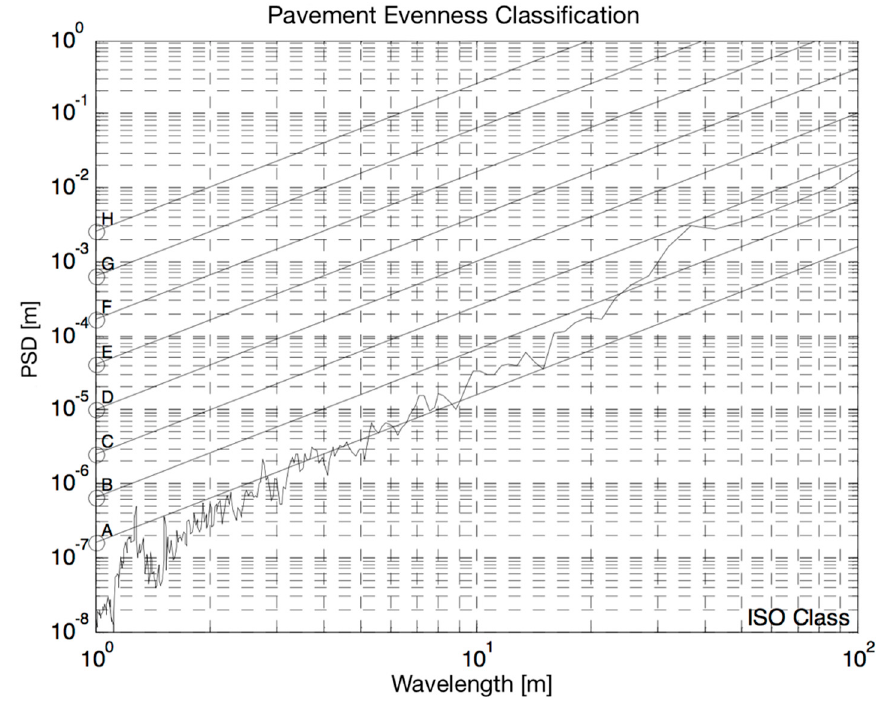
Figure 25. Evenness classification according to ISO 8608 (1995) [217] (modified from Barbosa, 2011 [218], Figure 8; reprinted under CC BY-NC 4.0 suggested by Dr. Francisco Ricardo Cunha, Editor-in-Chief of the J. Braz. Soc. Mech. Sci and Engn).